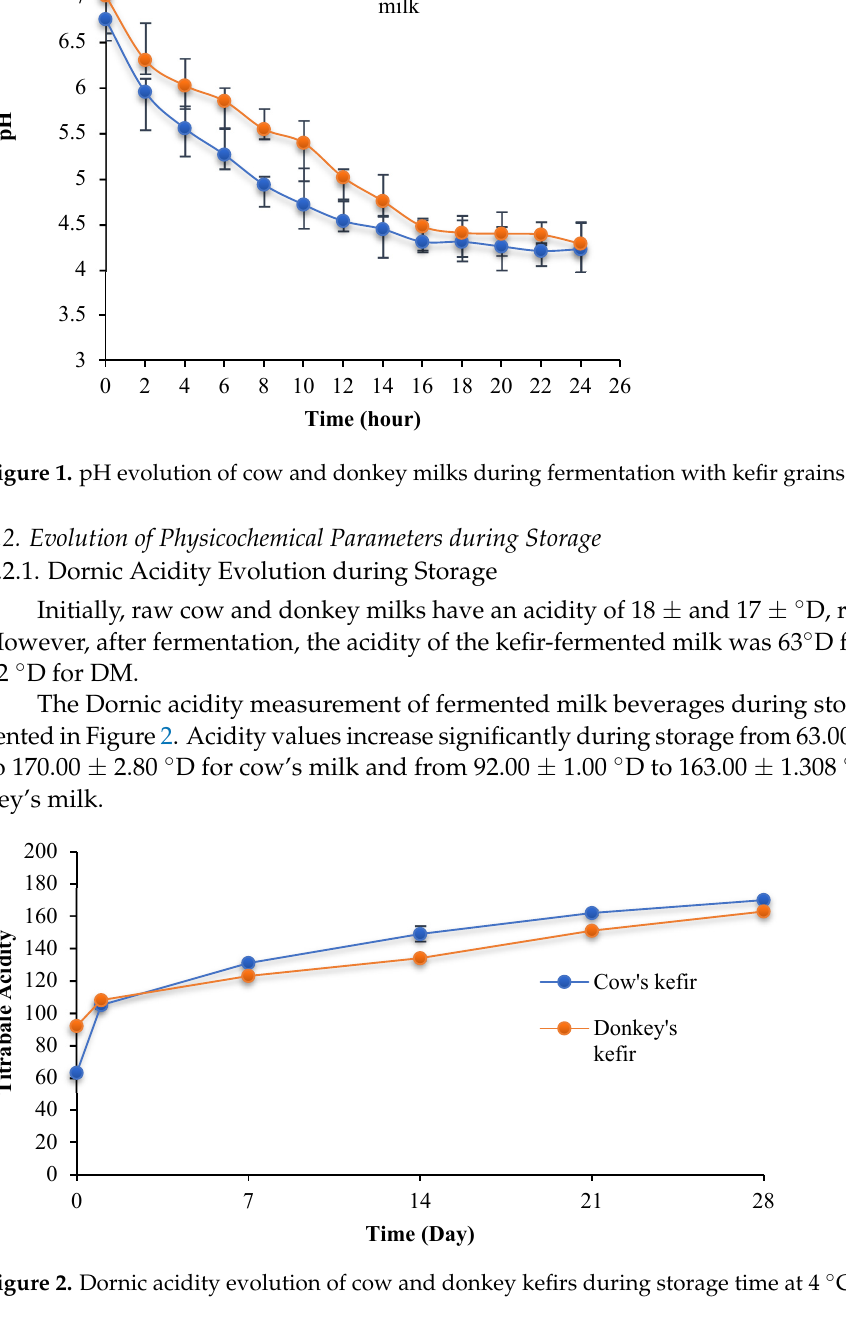
Figure 2. Dornic acidity evolution of cow and donkey kefirs during storage time at 4 °C.